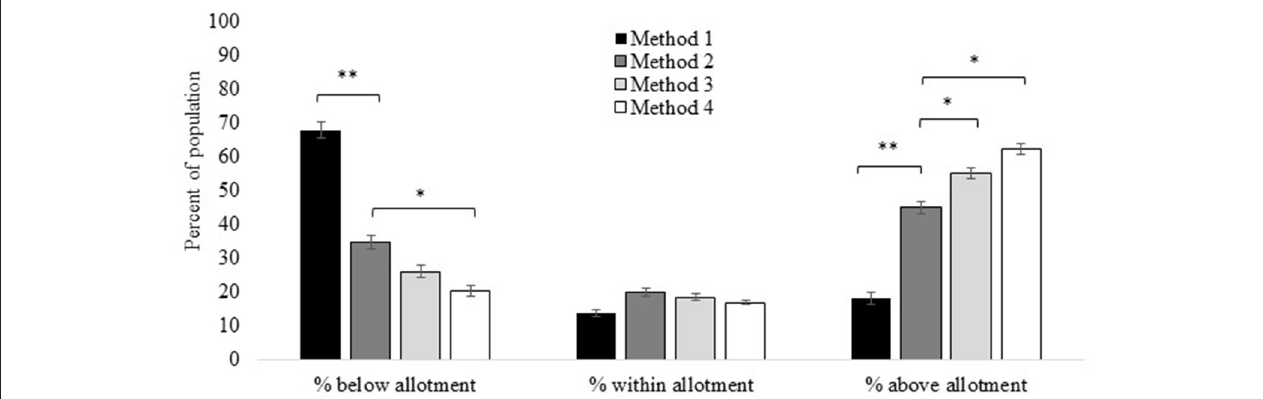
FIGURE 4 | Red meat intakes compared to allotment ranges in the US 2020–25 Dietary Guidelines for Americans recommended eating patterns estimated via different methods. Method 1: Unprocessed red meat, includes beef, veal, pork, lamb, and game meat; excludes organ meat and processed meat. Method 2 (reference): Total red meat, includes unprocessed red meat and processed red meat. Method 3: Red and processed meat, includes unprocessed red meat, processed red meat, and processed poultry. Method 4: Red and processed meat, additionally including chicken patties, nuggets, and tenders. See Figure 1 for further descriptions of each method. Results are shown as mean ± SEM via the NCI Method for usual dietary intakes. *Difference from Method 1 estimate (effect size) is ≥ 10%; **difference from Method 1 estimate is ≥ 20%. Data source: US Centers for Disease Control and Prevention/National Center for Health Statistics, NHANES 2015-2018, day 1 and 2 dietary recall